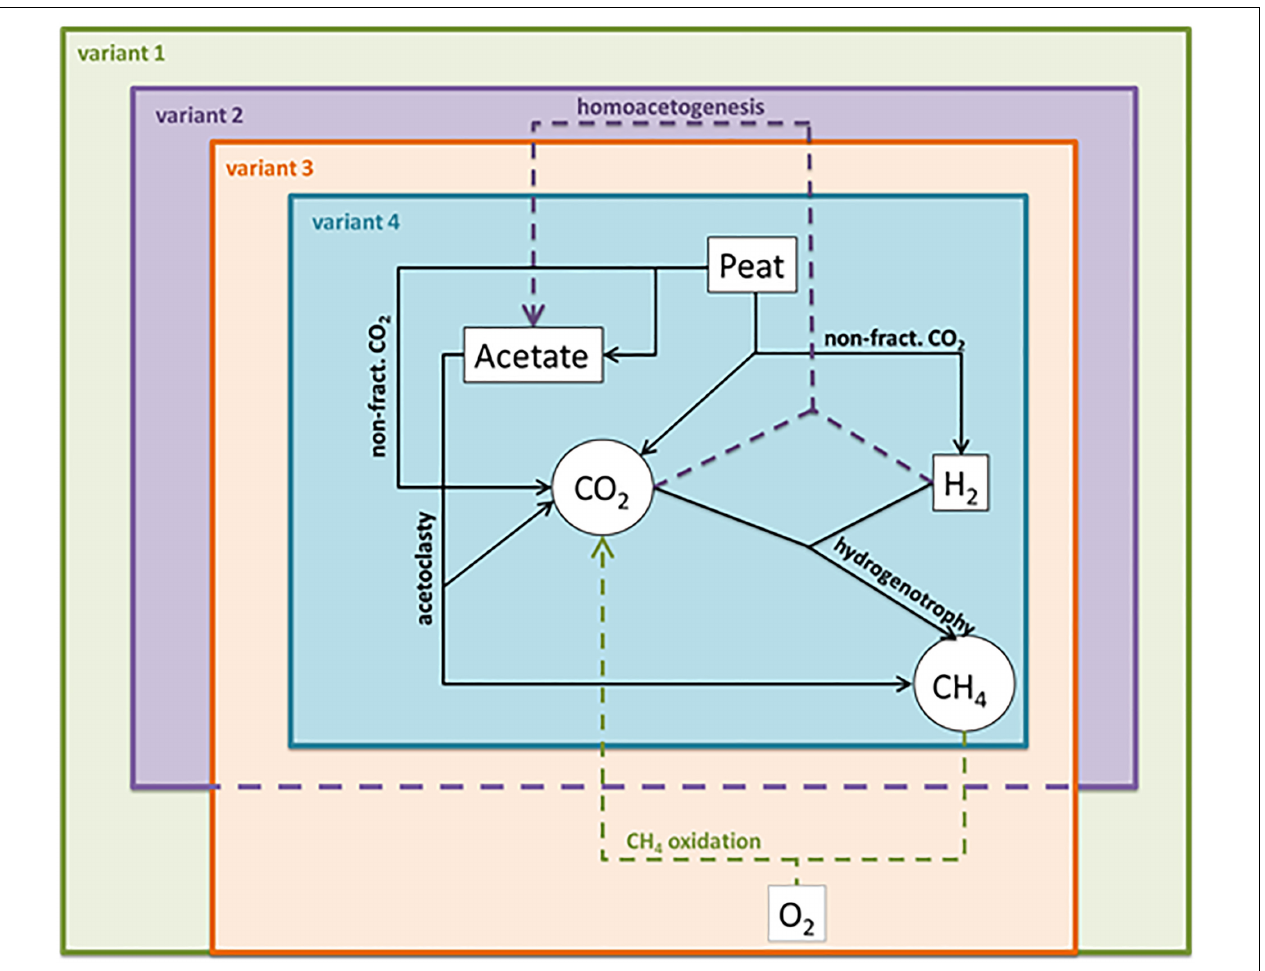
FIGURE 2 | Schematic overview of model variants showing included reaction pathways in each variant. Neumann et al’s. (2016) fugitive methane term was not included in any model variant because the closed incubations should not have allowed gasses to escape the system. Variant 1 is the most inclusive, incorporating all reactions, variant 2 excludes CH 4 oxidation, variant 3 includes CH 4 oxidation, but excludes homoacetogenesis, and variant 4 excludes both CH 4 oxidation and homoacetogenesis.